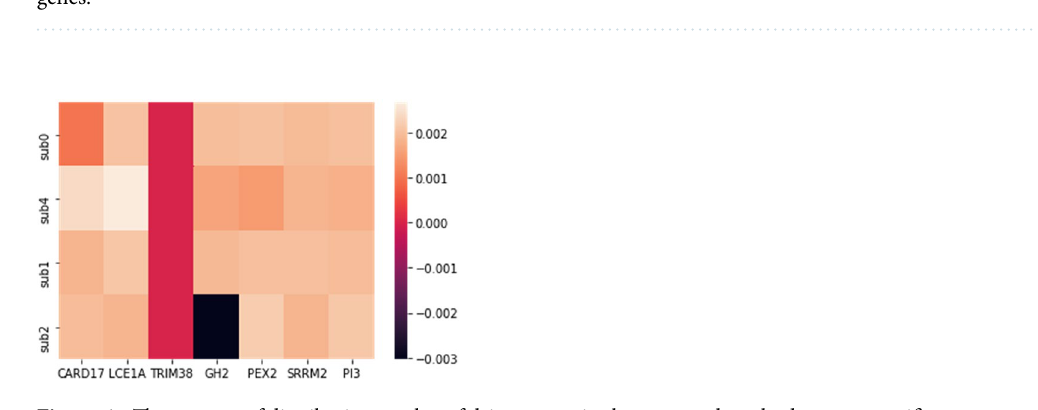
Figure 5. Overlap of the number of suggested genes with specific subgroups of 100, 200 and 500 genes of driver genes.